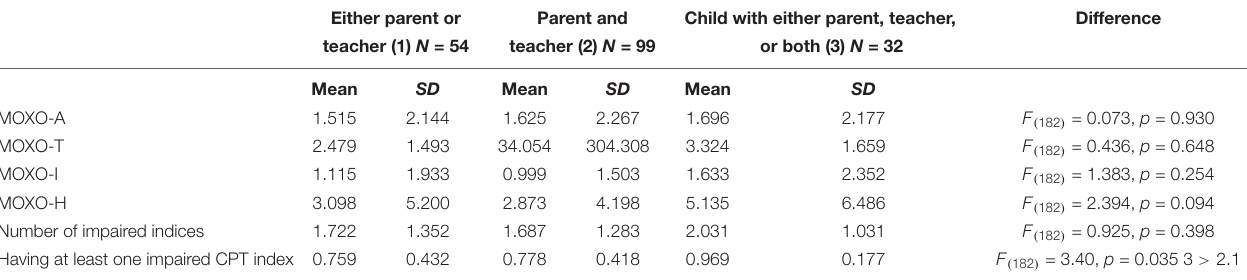
TABLE 4 | Group differences in CPT performance. Either parent or Parent